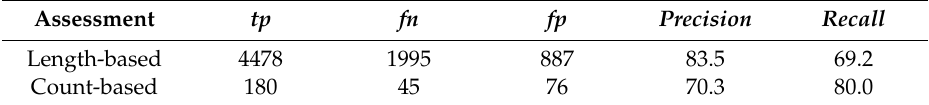
Figure 7. Abbreviations: tp = true positive, fn = false negative, fp = false positive.